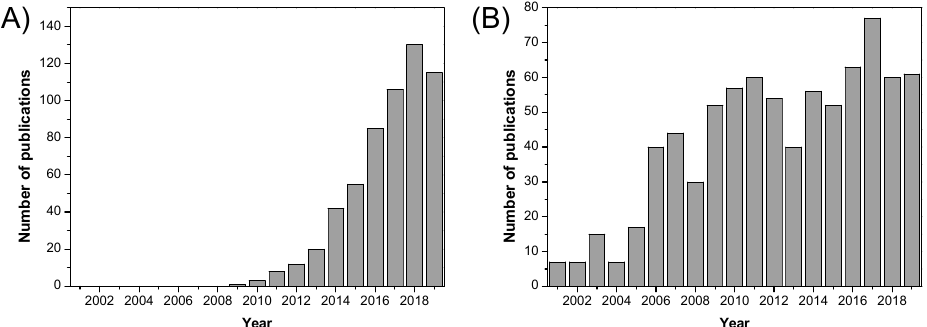
Figure 17. Number of publications in the period of 2001–2019 indexed in the Web of Science: ( A ) keywords: graphene oxide AND fuel cell AND proton exchange membrane; and ( B ) keywords: carbon nanotube AND fuel cell AND proton exchange membrane. Source: